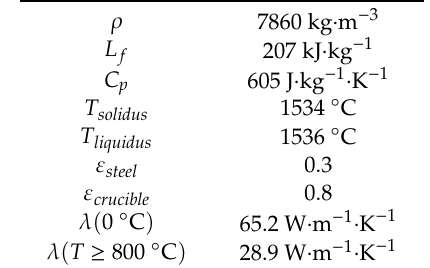
Table 5. Thermodynamic values of steel alloy, data from